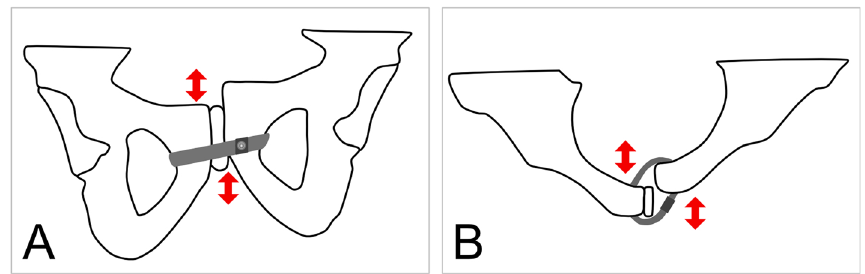
Figure 8. Complication that may occur using trans-obturator cable fixation. ( A ) Horizontal dislocation of the pubic rim is possible because of shear stress. ( B ) In case of a very unstable posterior pelvic ring that has not been stabilized, dislocation of the pubic rim in the axial plane may be a